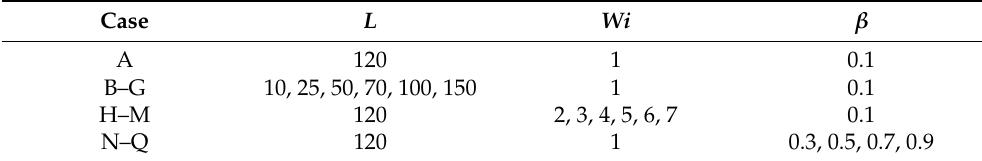
Table 2. Parameters for the pipe flow cases. Wi , L , and β represent the Weissenberg number, maximum extensibility of the polymer molecule, and the solvent viscosity ratio, respectively. Case